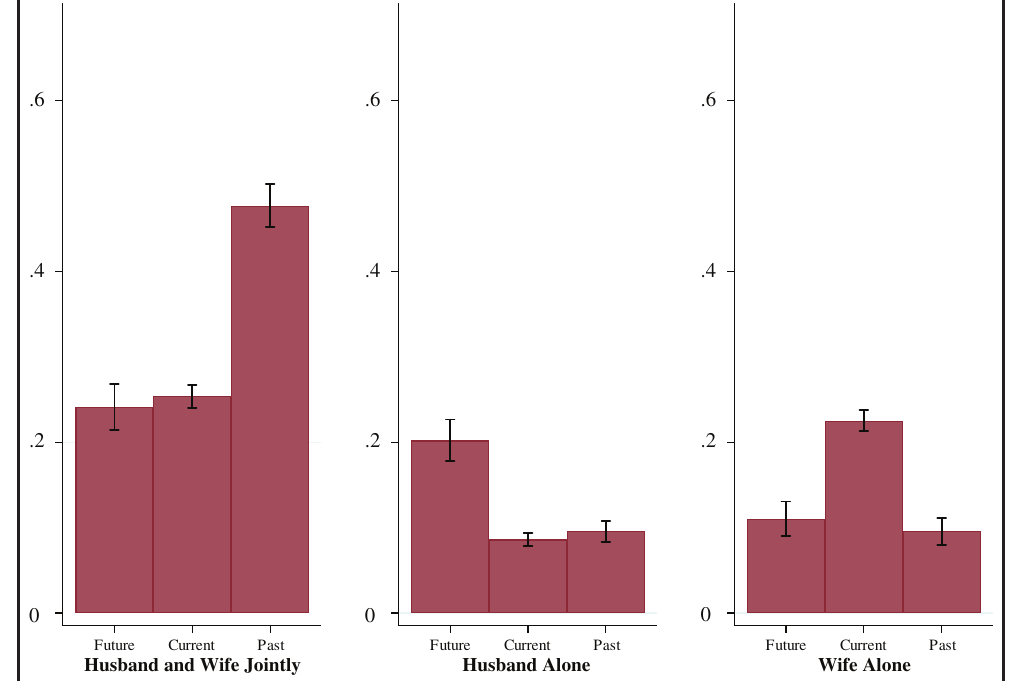
Figure 1 Fraction of decisions made jointly/alone across husband’s migration